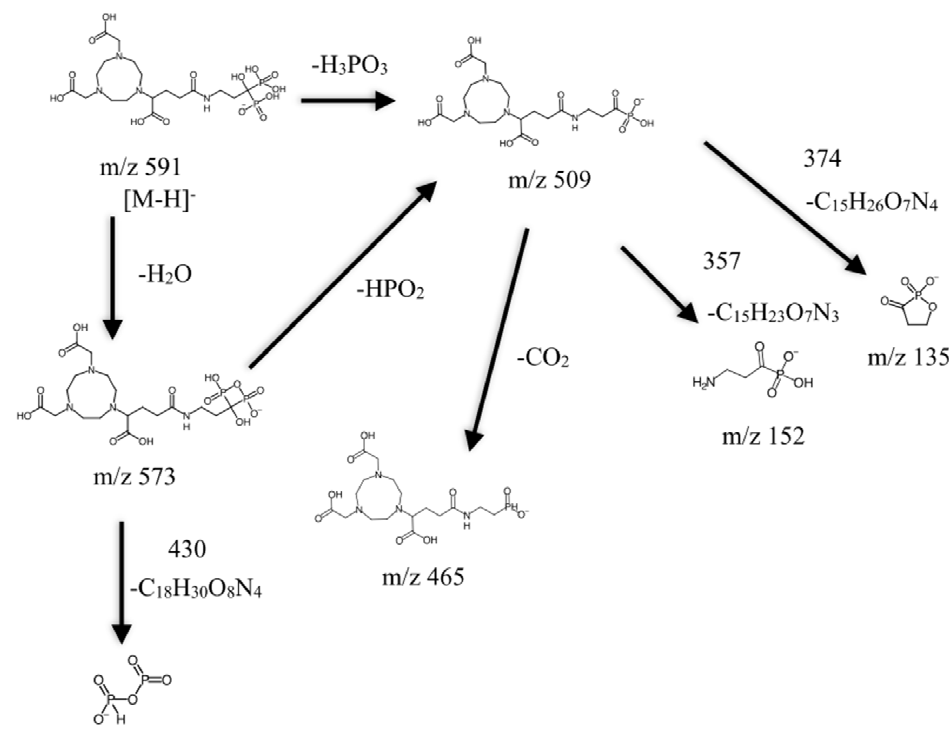
Figure 12. Proposed ( − ) ESI ‐ MS n fragmentation pathway for NODPAM. Table 6. The relative error (ppm) and RDBE for each fragment produced from the MS/MS analysis. Relative Error Obtained m / z Exact m / z RDBE Molecular Formula (ppm)